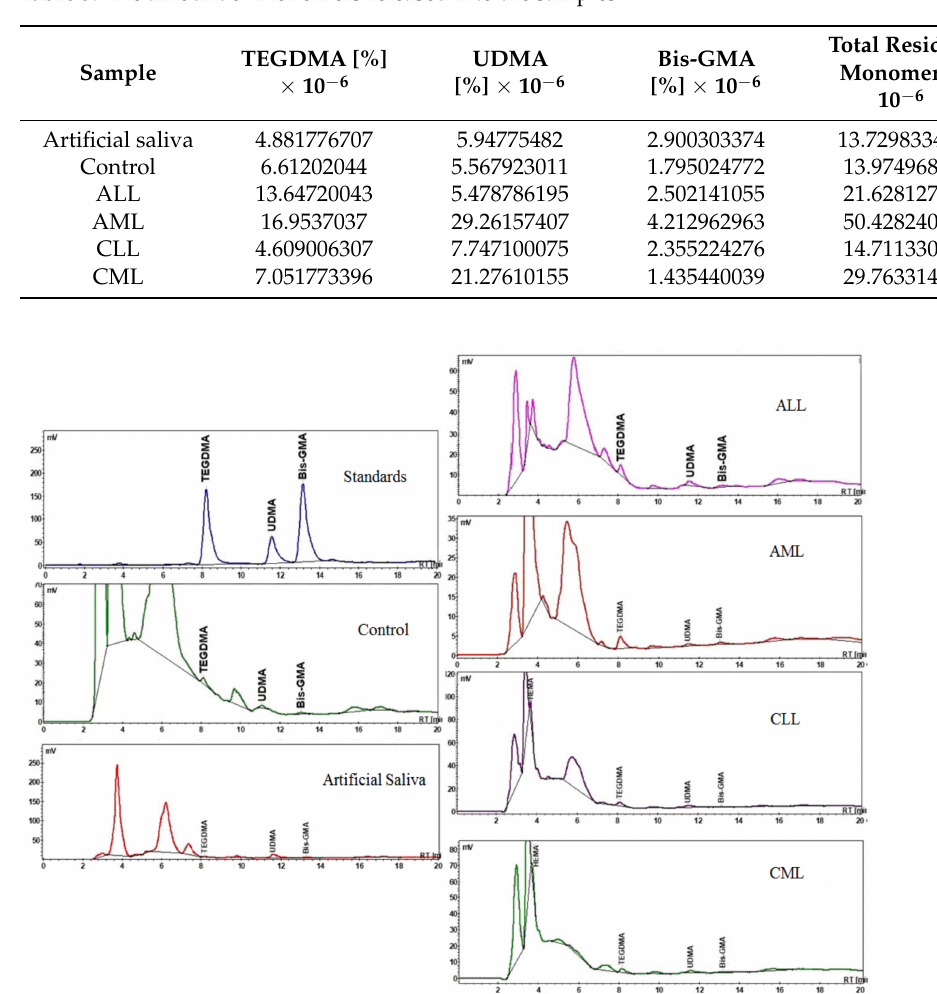
Table 5. The amount of monomers released into the samples.